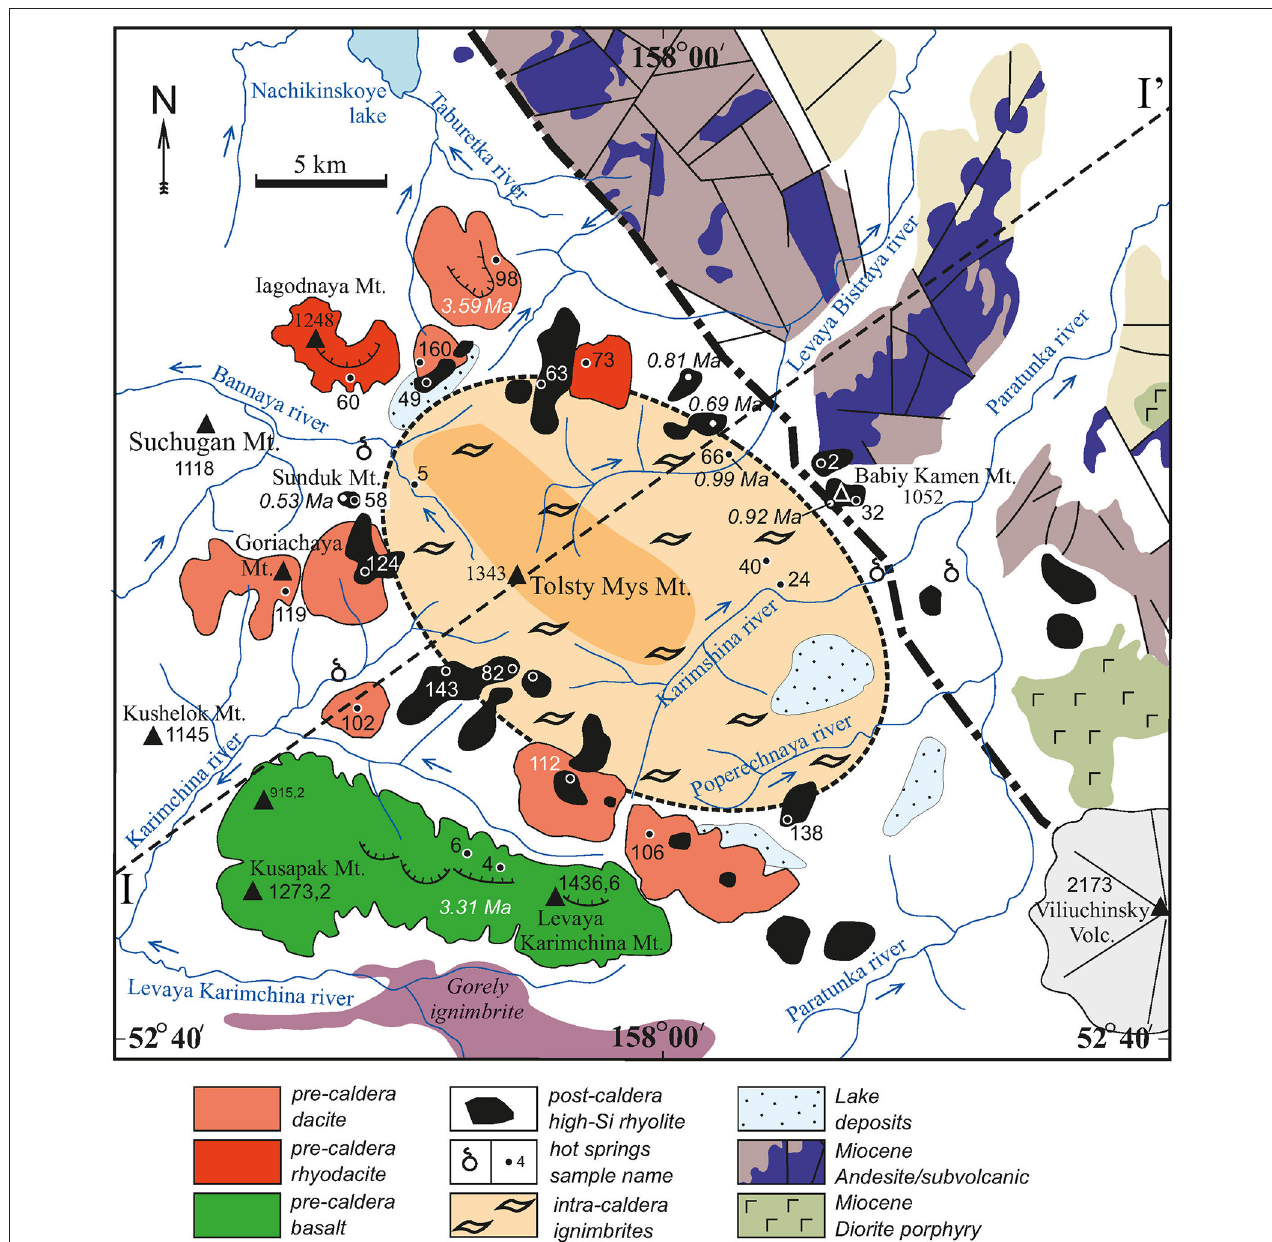
FIGURE 2 | A geologic map of Karymshina Volcanic Complex showing topographic features, inferred 1.78Ma Karymshina caldera boundary (dashed line), pre- and post-caldera extrusive domes and volcanoes. Numbers represent ages from this study ( Table 2 ) and compiled from the literature ( Table 1 ). The last two-three digits of sample names from this study (e.g., 119 is 119L-2005) corresponds to the Table 1 . The area of the caldera contains several ignimbrite sheets, which reach visible thicknesses of 1,000m on the eastern edge and contain no observable stratigraphic compositional differences ( Table A1 ). These ignimbrite sheets wedge out as they approach the edges of the depression near the volcanoes Goryachaya, Yagodnaya, and Sunduk. The volcanic products of those volcanoes and additional large extrusions overlay the ignimbrite sheets along the supposed ring fracture. Miocene porphyries include granodiorites from 11 to 14Ma Zavoikovsky complex and 11.4Ma Akhomten granitic complex is to the southeast ( Figure 1 ). Dashed line I and I ′ represent geophysical profile from Geological Map of the Russian Federation (2000) shown on Figure 3 .